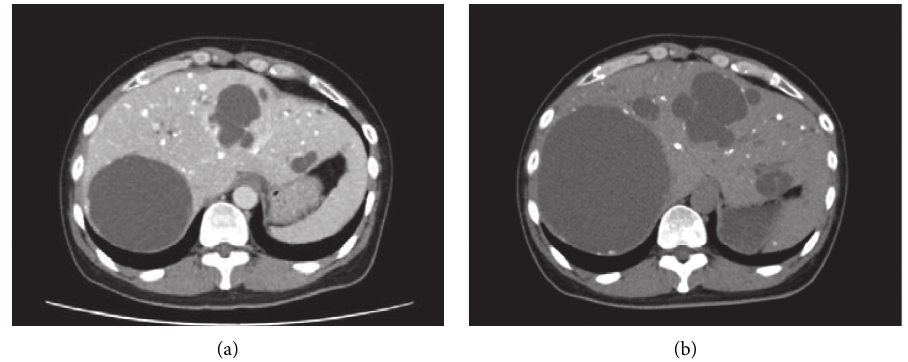
Figure 2: Computed tomography revealed that the liver cysts were increased in size after vandetanib treatment. (a) At 42 months after vandetanib treatment initiation. (b) At 48 months after vandetanib treatment initiation, abdominal distension